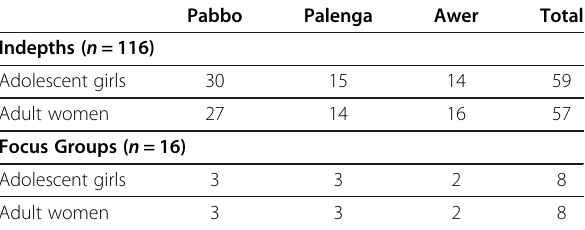
Table 1 Breakdown of sample based on IDP